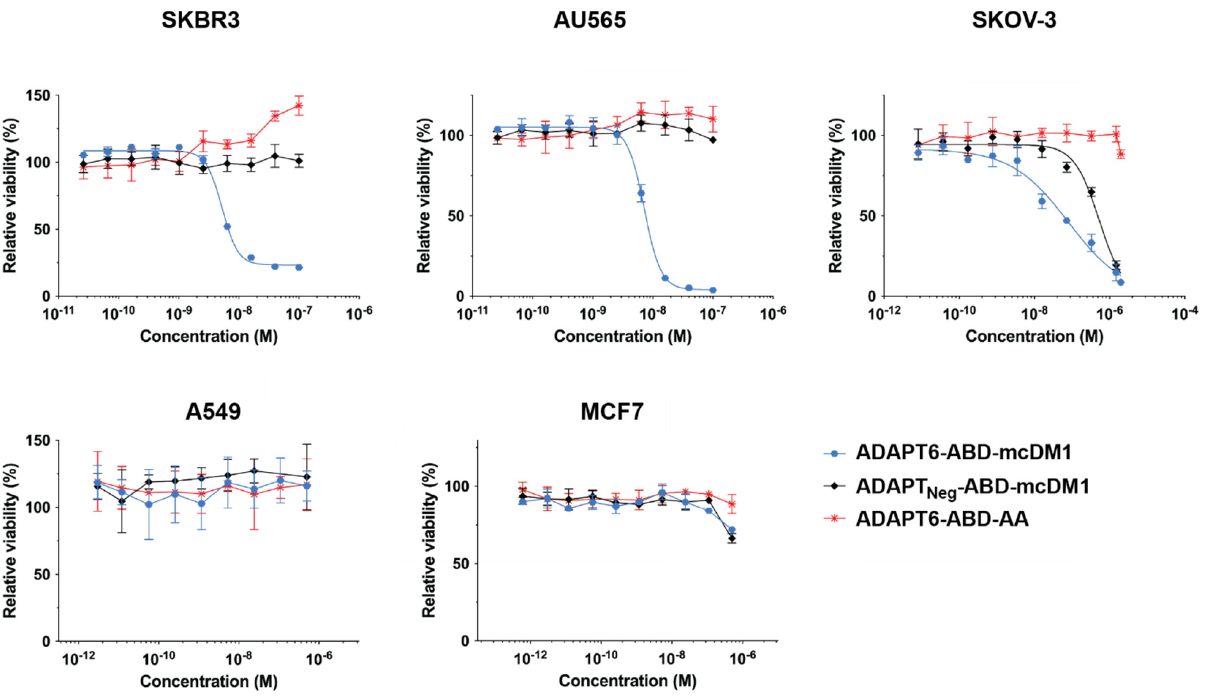
Figure 3. In vitro cytotoxicity of the ADAPT constructs. The cytotoxicity was measured by the treatment of different cell lines, as indicated above the panels, with serial dilutions of the conjugates. The viability at each data point was normalized to the viability of each cell line in complete media without conjugate (which was set to 100%). Each data point is an average of four replicates of each concentration ± 1 SD.